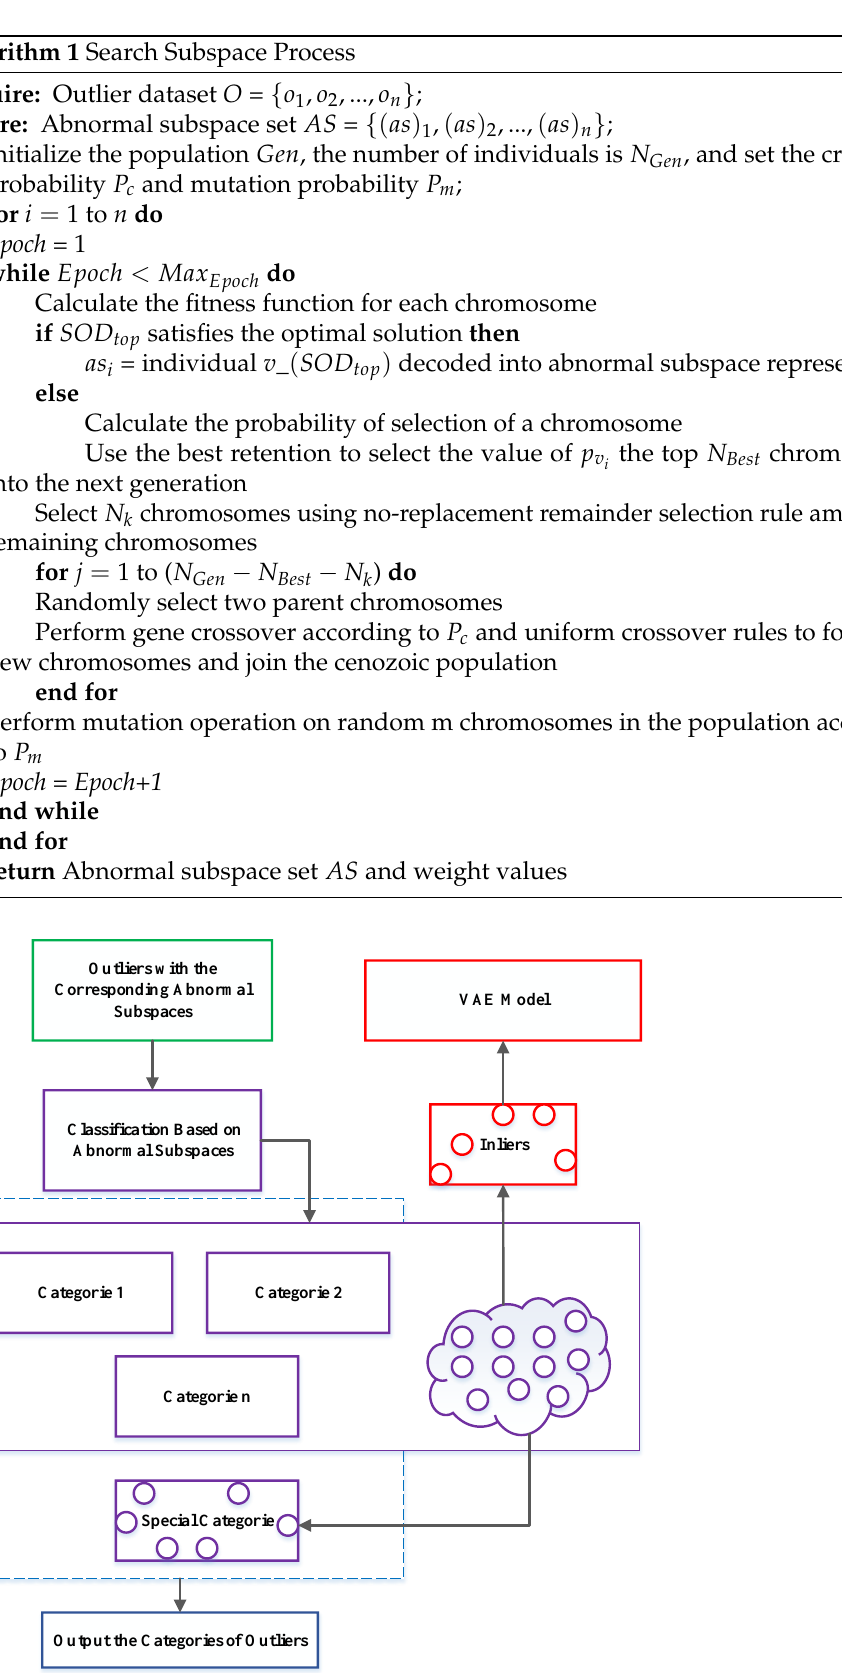
Figure 9. Outlier sub-classification and false positive feedback process based on abnormal